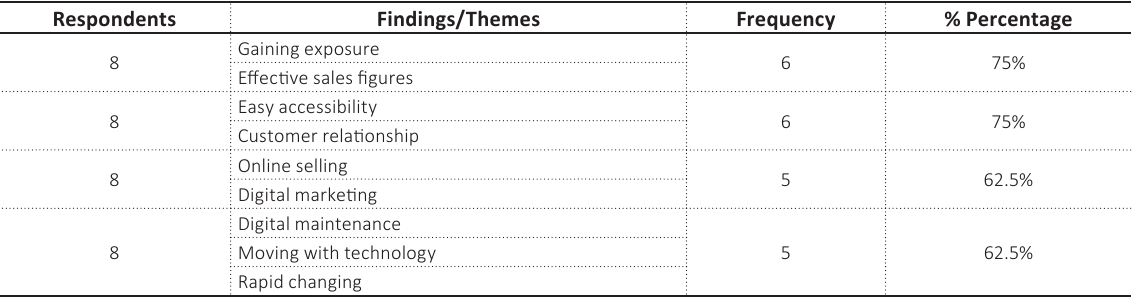
Table 3. Responses rate percentage on